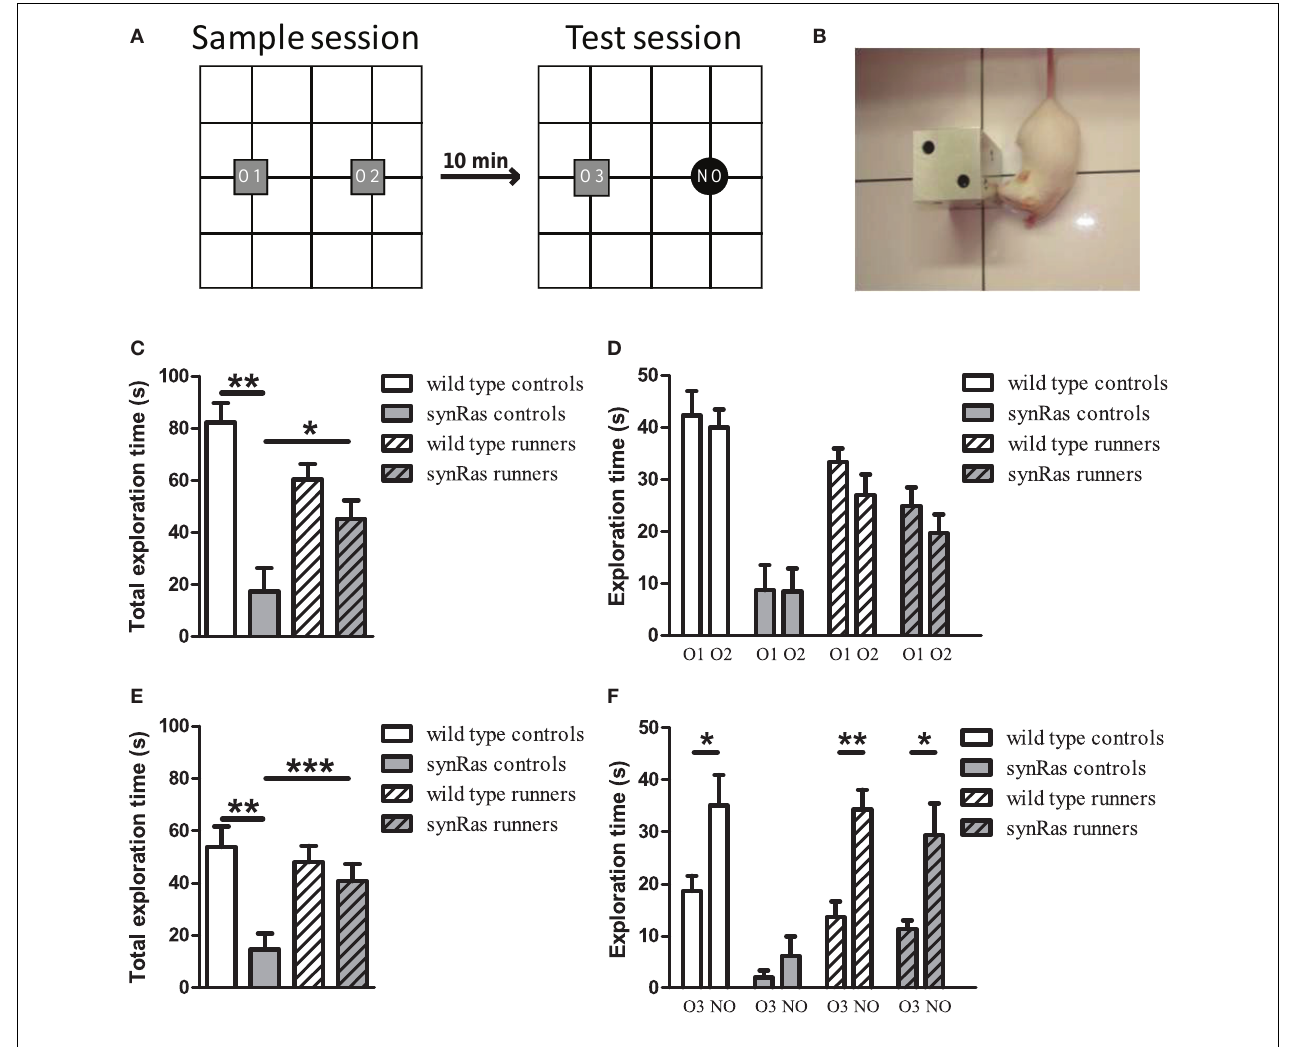
FIGURE 5 | Effects of physical activity on object recognition memory. (A) Schematic representation of the experimental protocol. During the sample session, mice were exposed to two identical objects O1 and O2. During the test session, mice were exposed to a triplicate of the familiar object O3 and a novel object NO. (B) Example of a snout contact with an object. (C) Total exploration duration during the sample session.